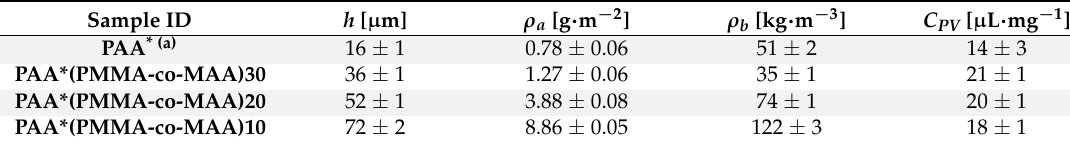
(a) Single-layer membrane control of thermally-crosslinked PAA (a) Single ‐ layer membrane control of thermally ‐ crosslinked PAA fibres.